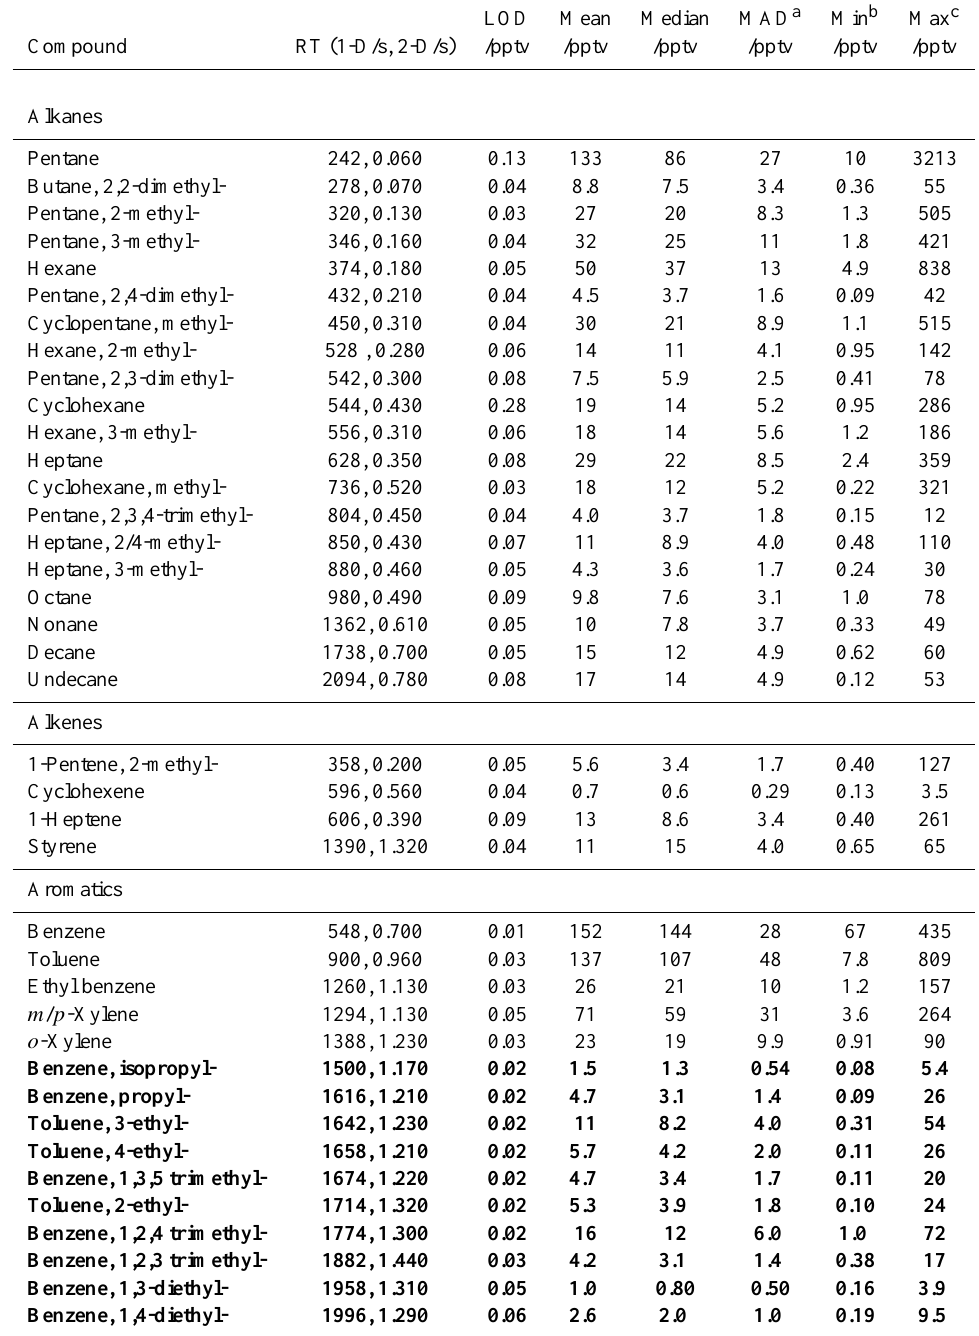
Table 2. VOC mixing ratios measured by GC × GC-TOFMS during the winter RONOCO campaign for all samples taken. Bold text shows additional aromatic species featured in this additional reactivity